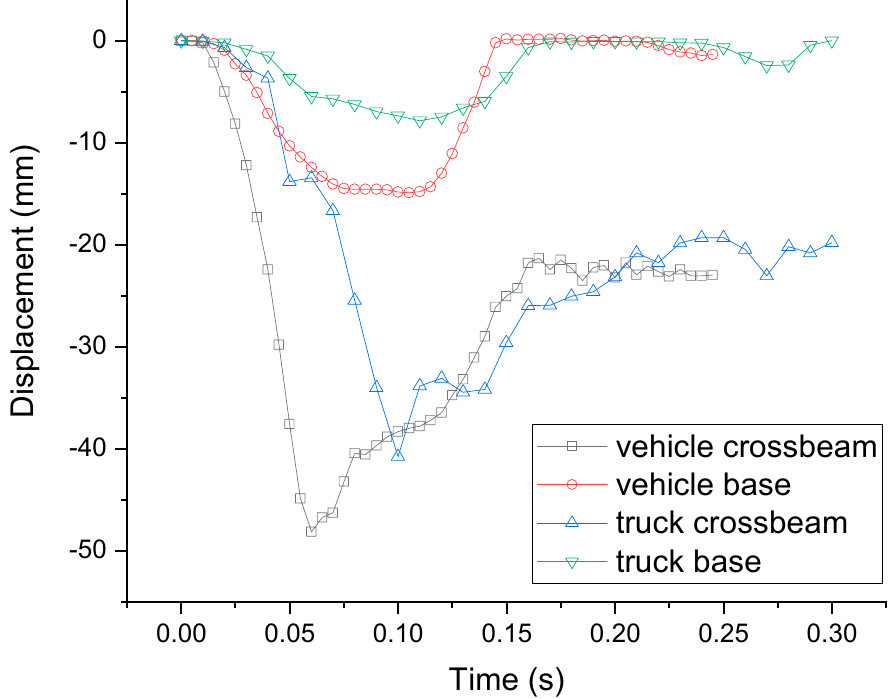
Figure 14. Displacement–time curve of the guardrail base and beam in the y direction (transverse bridge direction).